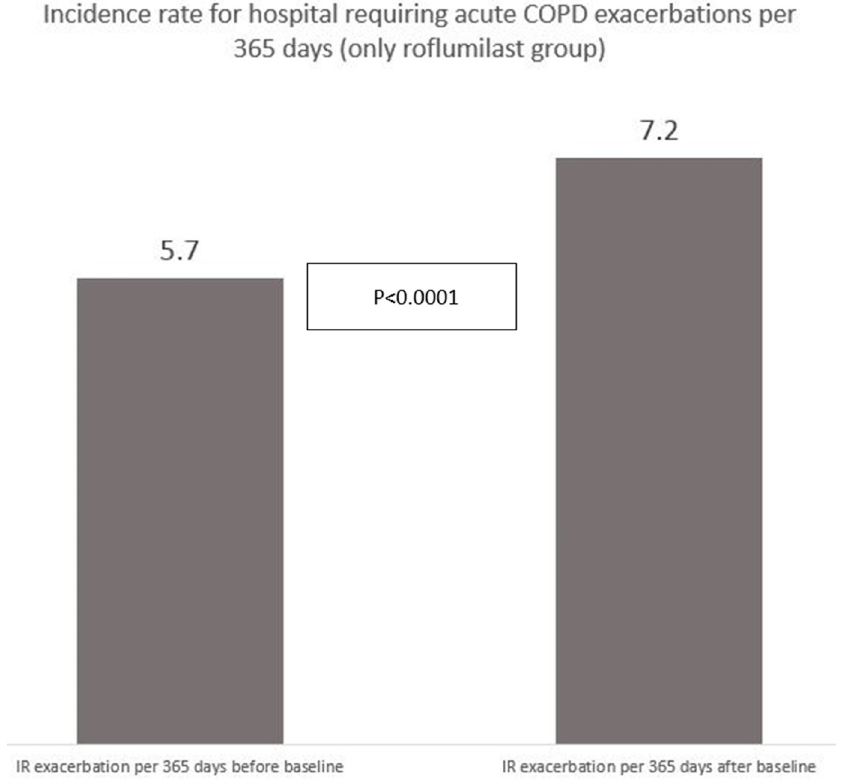
Figure 5. Incidence rate of hospitalization-requiring acute exacerbations for 594 participants receiving roflumilast before and after starting up with roflumilast (AECOPD/365 days). All endpoints analyses of 30 days, 90 days, 180 days, and 365 days showed overall an unchanged signal compared to the main analysis. We then combined the endpoint AECOPD with hospitalization-requiring pneumonia and the results pointed overall in the same direction as the separate endpoints (propensity-matched population: HR 1.7, 1.5 to 1.9 p < 0.0001; theophylline-